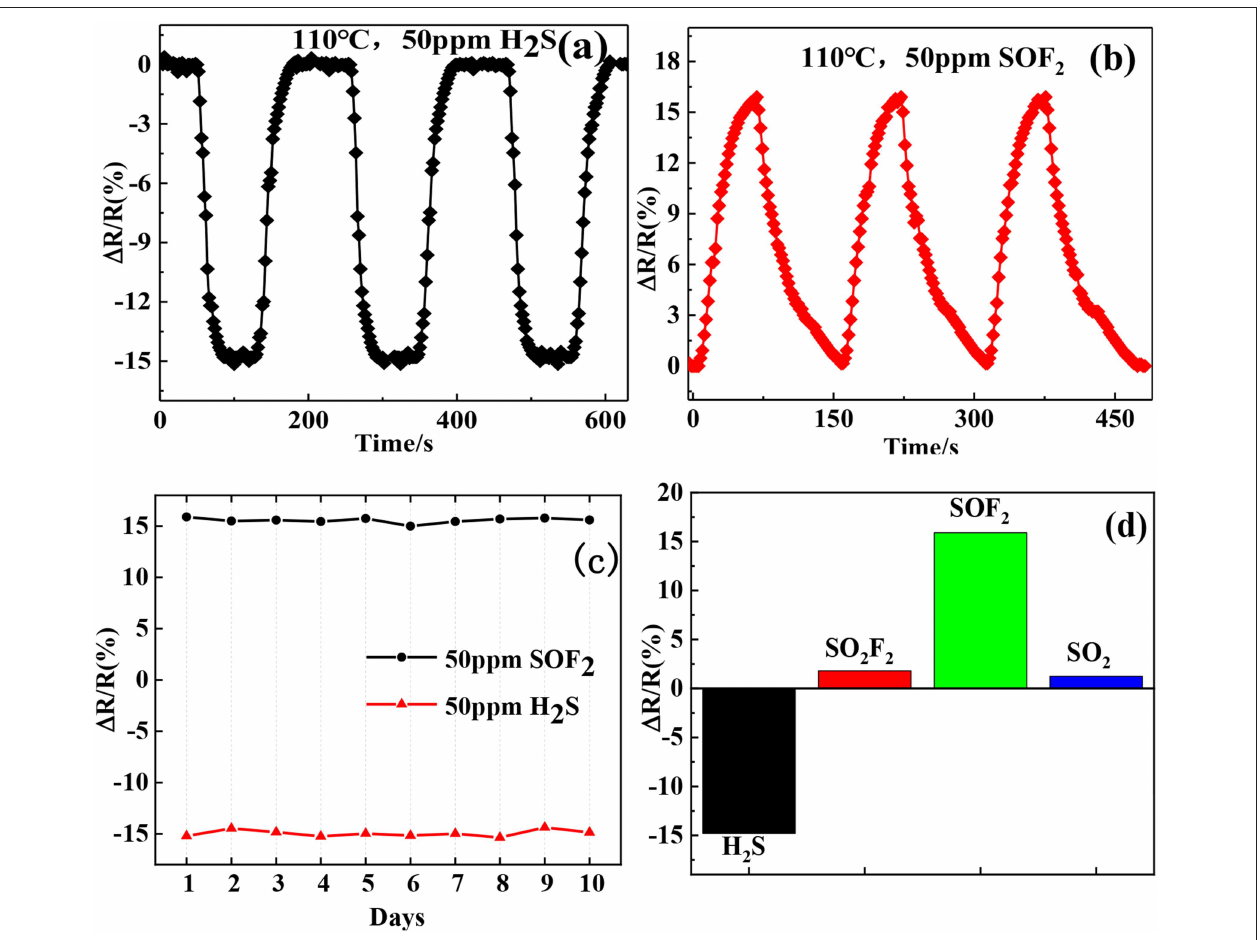
FIGURE 10 | Repeatability curve of Au/SnO 2 /RGO sensor exposed to (a) 50 ppm H 2 S and (b) 50 ppm SOF 2 ; (c) the long-term stability of Au/SnO 2 /RGO sensor exposed to 50 ppm H 2 S and SOF 2 . (d) selectivity of Au/SnO − 2 /RGO sensor toward 50 ppm H 2 S, SO 2 F 2 , SOF 2 , and SO 2